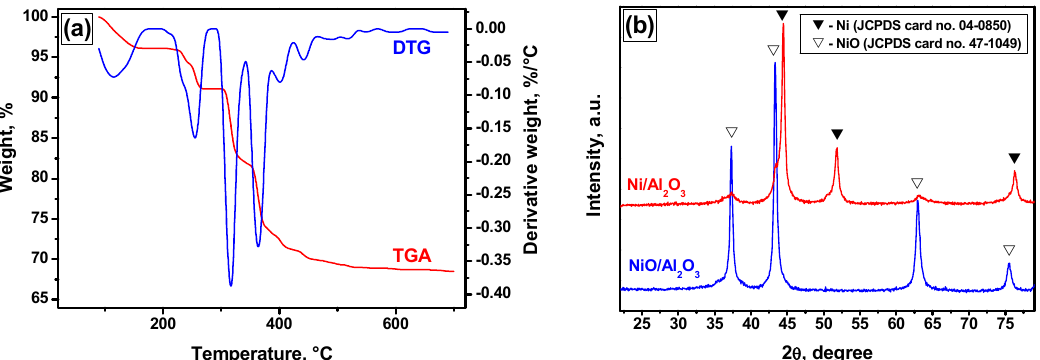
Figure 1. Thermogravimetric analysis (TGA) and derivative thermogravimetry (DTG) profiles for ( a ) the reduction of 90% NiO/Al 2 O 3 precursor , ( b ) XRD patterns of the precursor and catalyst.